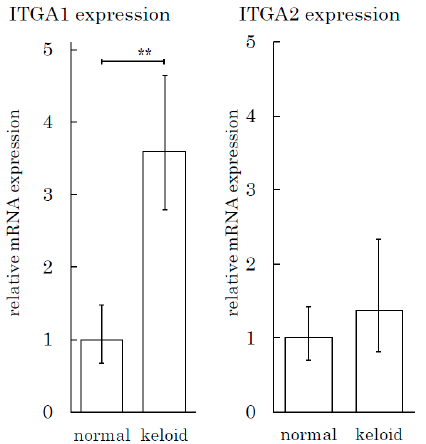
Figure 7. The Integrin α 1 expression level is high in keloid tissue relative to normal skin tissue. The real-time PCR analysis of integrins (ITGA1 and ITGA2) was performed for keloid and normal skin tissue samples. ** p < 0.01. n = 5 (KFs), 7(NFs).